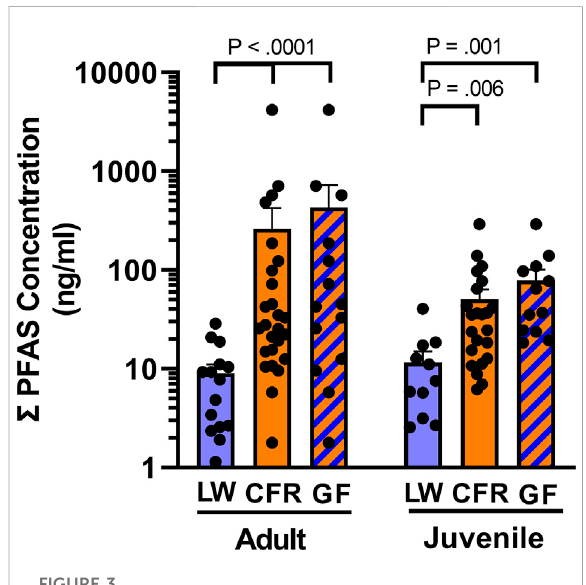
FIGURE 3 Total serum PFAS exposure. Mean of PFAS concentrations (ng/ml) found in serum of adult (SVL ≥ 90 cm) and juvenile American alligators from Lake Waccamaw (LW, adult n = 15; juvenile n = 11) and the Cape Fear River (CFR, adult n = 26; juvenile = 23), and the subset of animals from Green fi eld Lake (GF, adult = 14; juvenile =